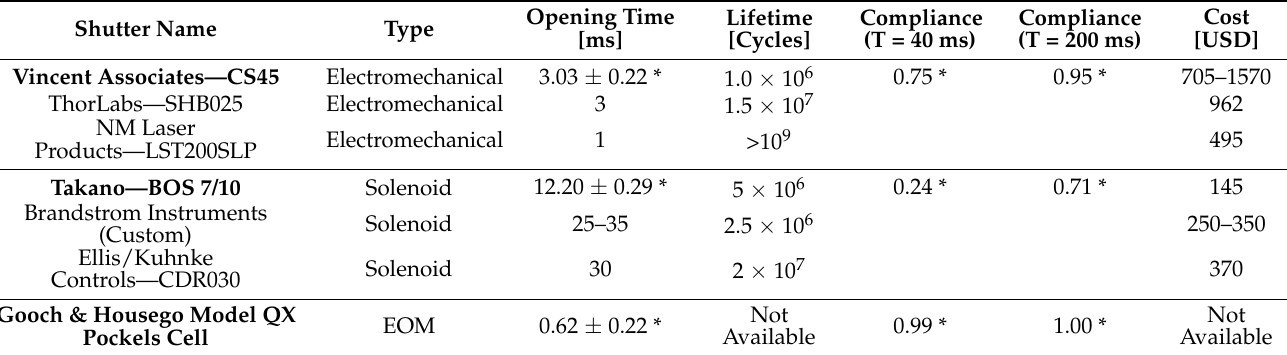
Table 1. Comparison of cost and performance characteristics of shutters. In the left column, the shutter models in bold font are the ones that were empirically tested in this report. Values marked with an asterisk (*) were measured experimentally. All other values are obtained from the